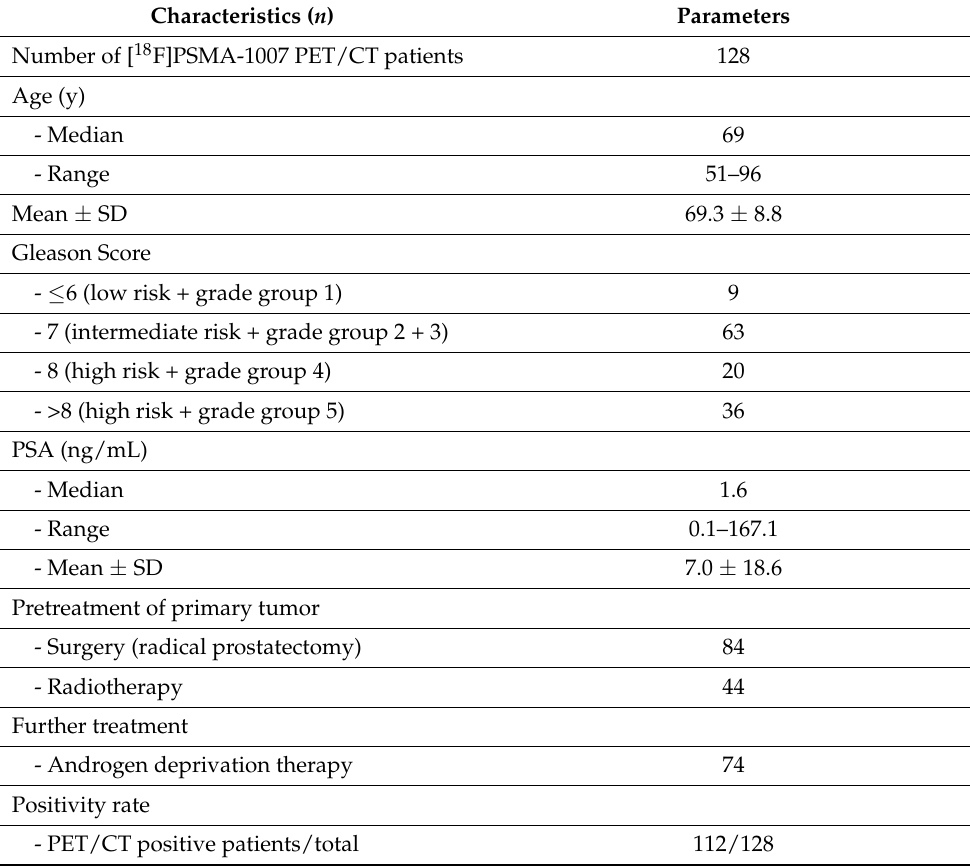
Table 1. Characteristics of 128 patients examined with restaging [ 18 F]PSMA-1007 PET/CT.